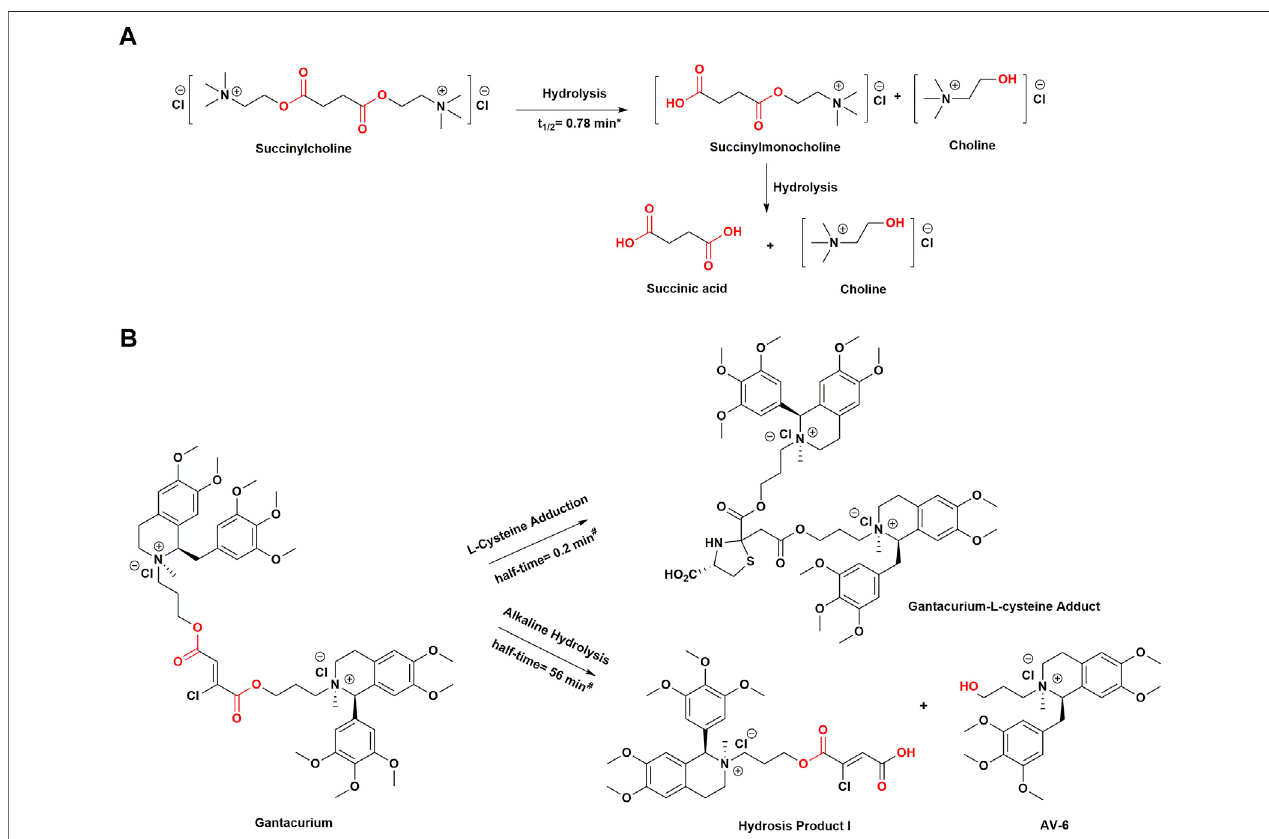
FIGURE 4 | Structural modi fi cations in muscle relaxants drugs with soft drug design. (A) Chemical structure of succinylcholine and its hydrolysis process. (B) Chemical structure of gantacurium and its breakdown products. *Values are from measurements of in vivo metabolic half-lives in human body. #Values are from measurements of in vitro reaction half-times in phosphate buffer at pH 7.4 and 37 ° C. t 1/2 ,